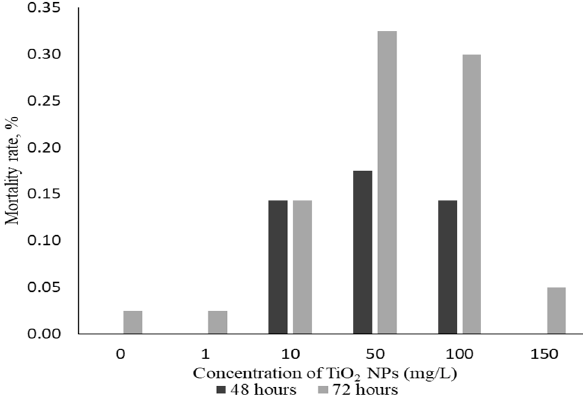
Figure 2. The percentage of the mortality rate of A. lanipes larvae exposed to different concentrations of TiO 2 NPs after 24, 48, and 72 h of exposure (N = 40 for each NP concentration). (Note: after 24 h of exposure, we observed no mortality in any exposed group or control).